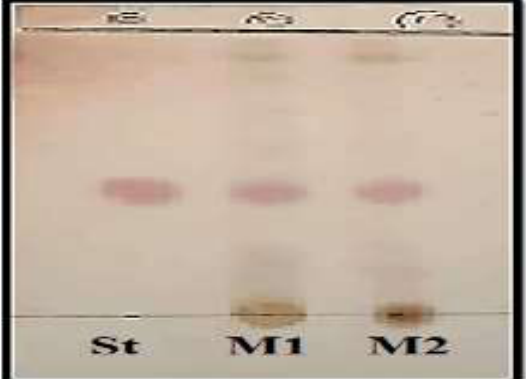
Figure 1. TLC chromatogram of (St: oleanolic acid standard, M1: ethyl acetate fraction by method 1, M2: extracted oleanolic acid by method 2) after derivatization with 5 % H2SO4 reagent and observation at daylight. .